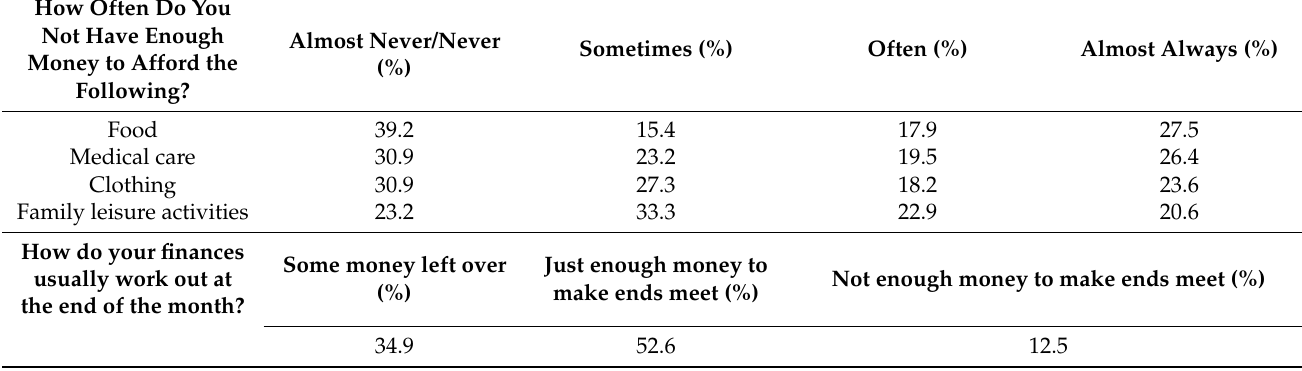
Table 3. The characteristics of the perceived financial strain of the sample ( n = 538).